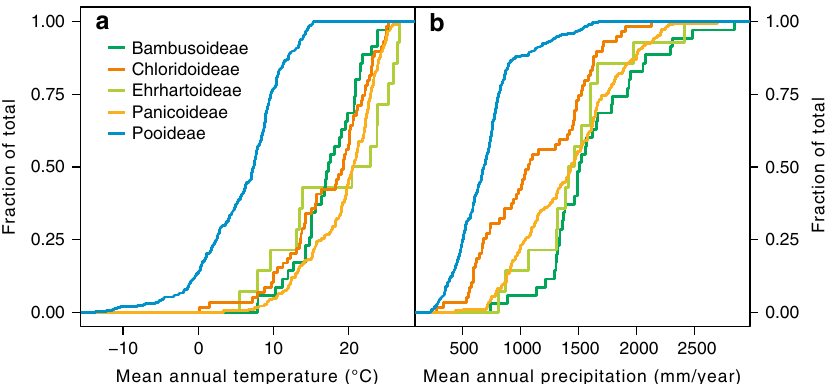
Fig. 2 Species accumulation curves for the climate parameters in China, sorted by the major grass subfamilies. a Species accumulation curves for mean annual temperature. b Species accumulation curves for mean annual precipitation. These data represent 598 species records in the Flora of China (http:// frps.iplant.cn/), while the collection localities are not necessarily in China. For data sources, see the Methods and Supplementary Note